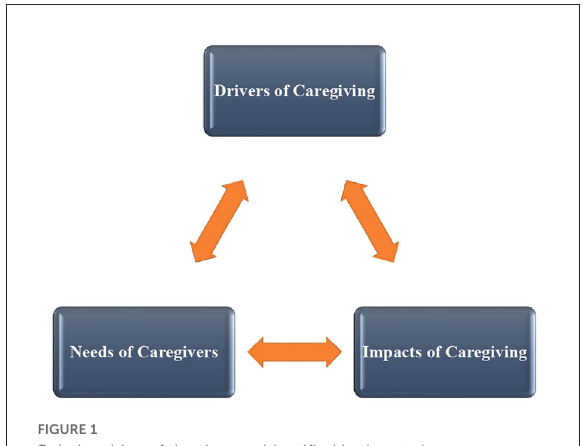
FIGURE1 Relationships of the themes identified in the